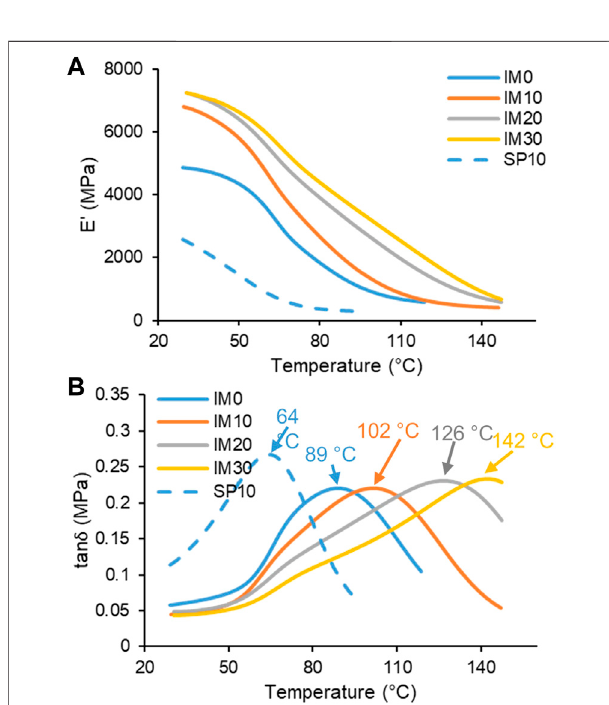
Frontiers in Materials |